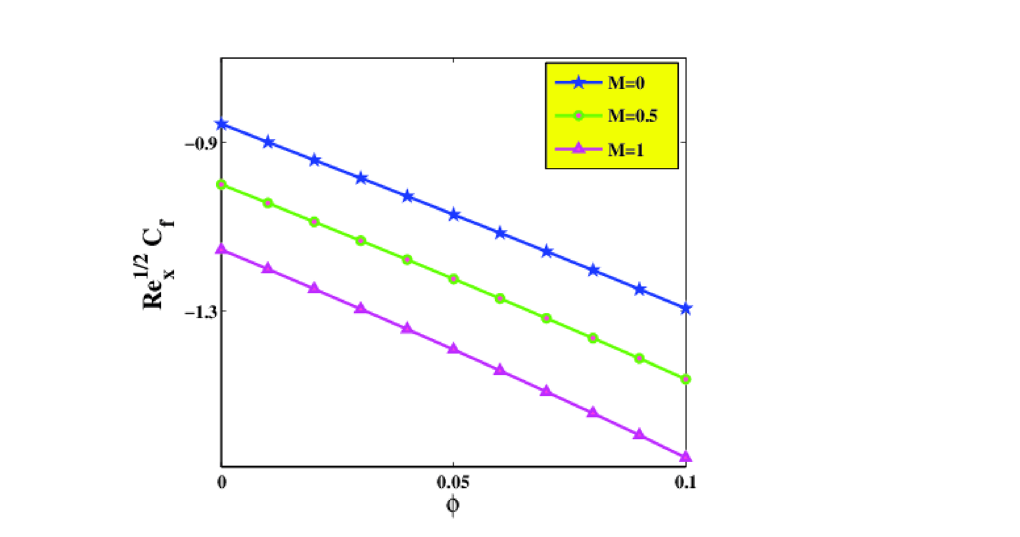
Figure 9. Temperature �(ϒ) via Ec and β .